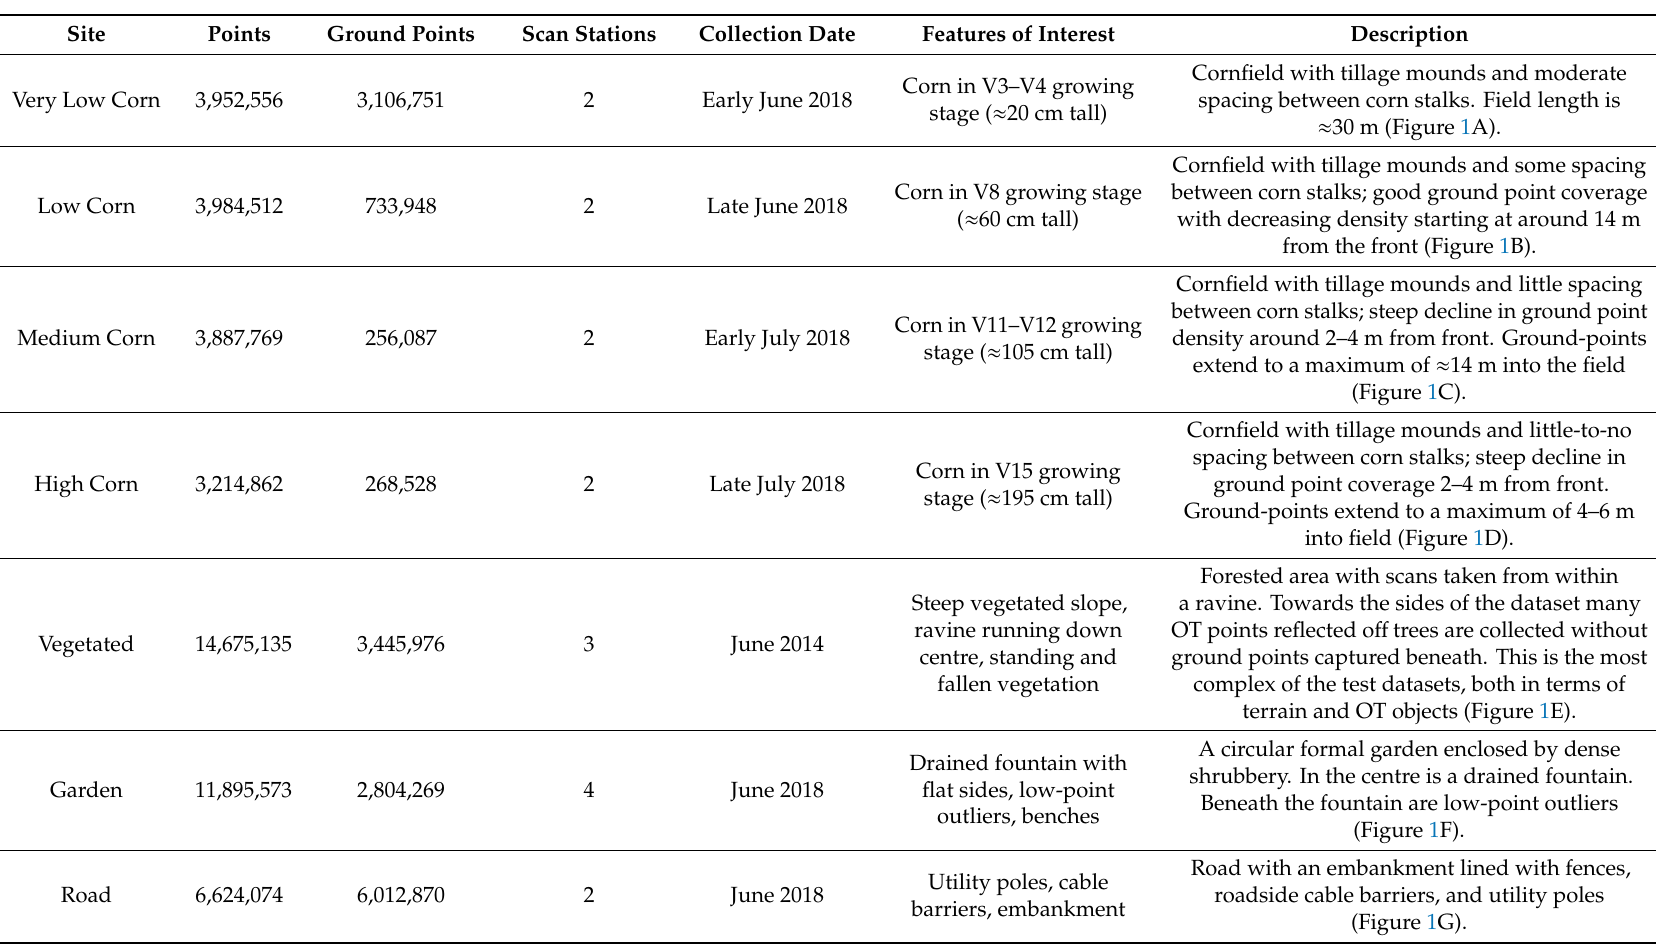
Table 1. Table outlining the terrain and object characteristics of interest for each of the seven study